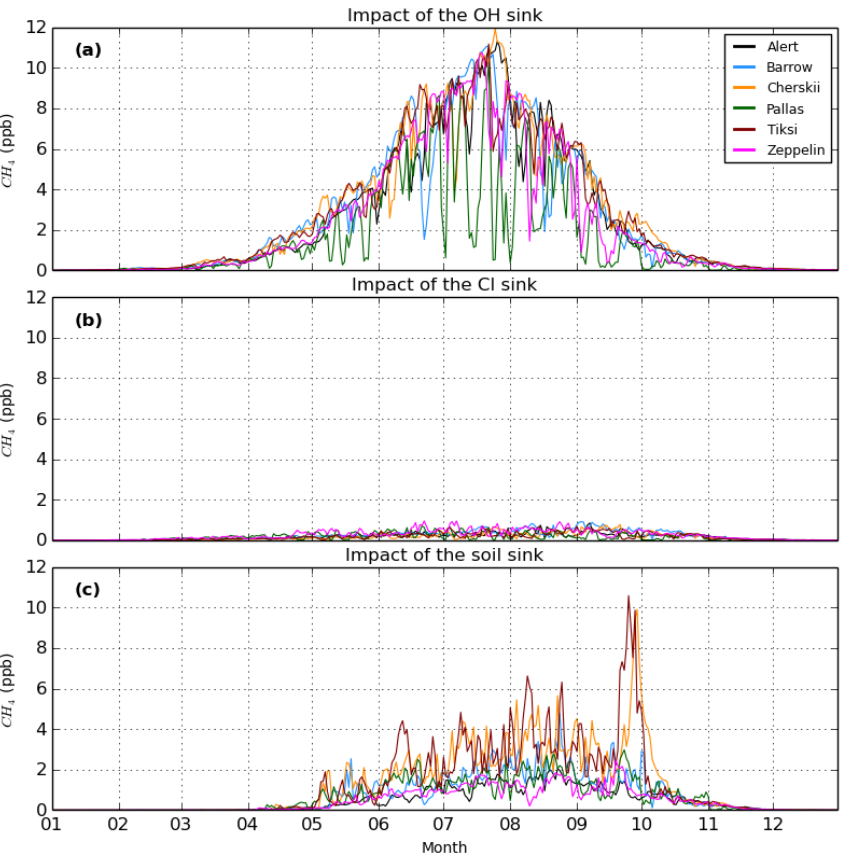
Figure 10. Difference between the reference simulation and (a) the simulation including the OH sink, (b) the one including the Cl sink, and (c) the one including soil uptake, at six measurement sites. Consequently, the impact of the sinks is shown here as positive